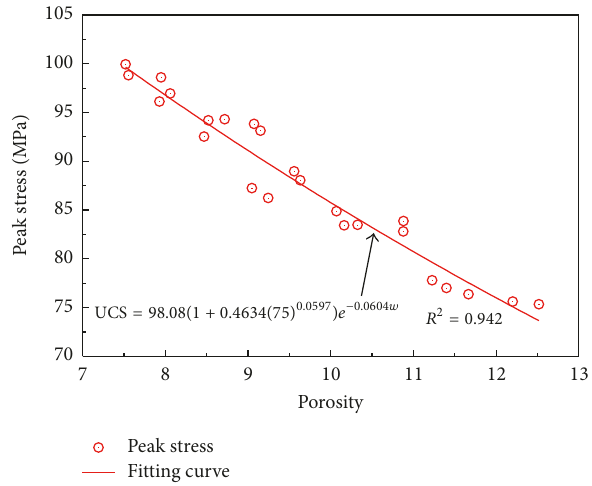
Figure 11: The relationship of NMR porosity and dynamic charac- teristics of